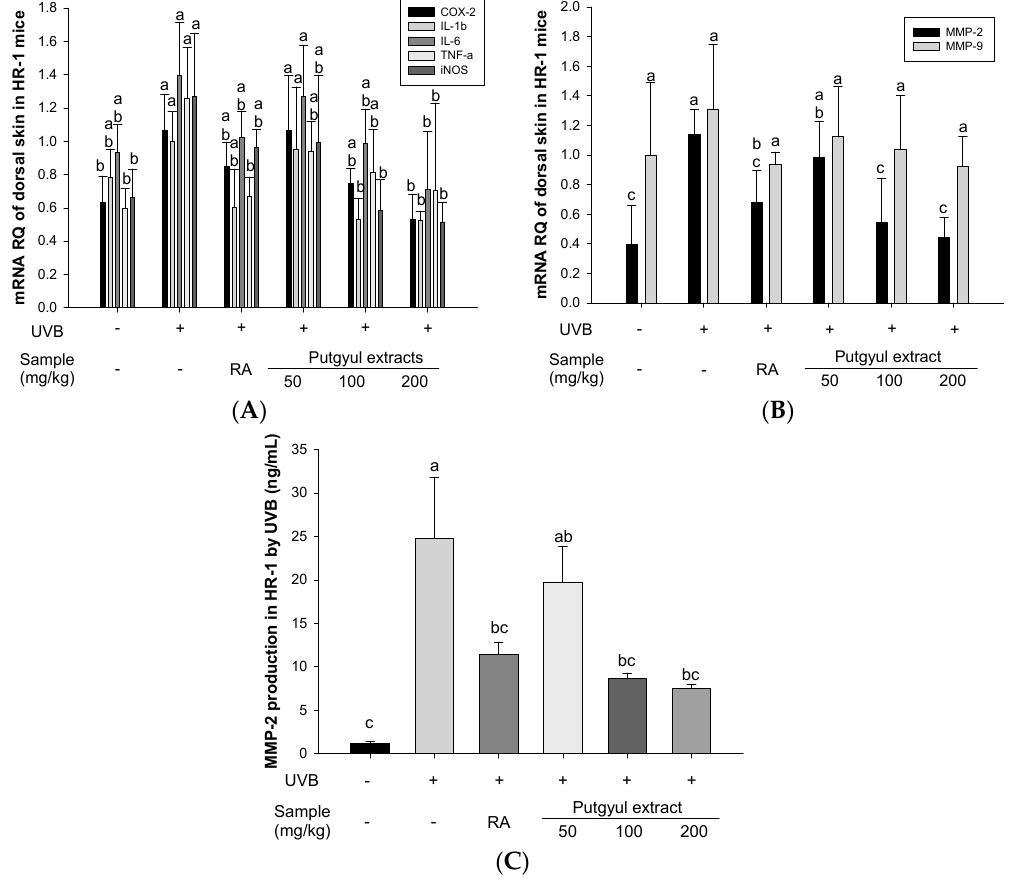
Figure 2. Effects of putgyul extracts on expression of cytokines and protein in ultraviolet-B (UVB)-induced hairless mice. ( A ) Expression levels of the inflammatory cytokines; ( B ) mRNA expression of MMPs; ( C ) MMP-2 protein expression. a–c All values are presented as mean ± standard deviation. Bars with different letters indicate statistically significant differences among the groups at p < 0.05 by one-way ANOVA. mRNA results are expressed as the relative quantity.